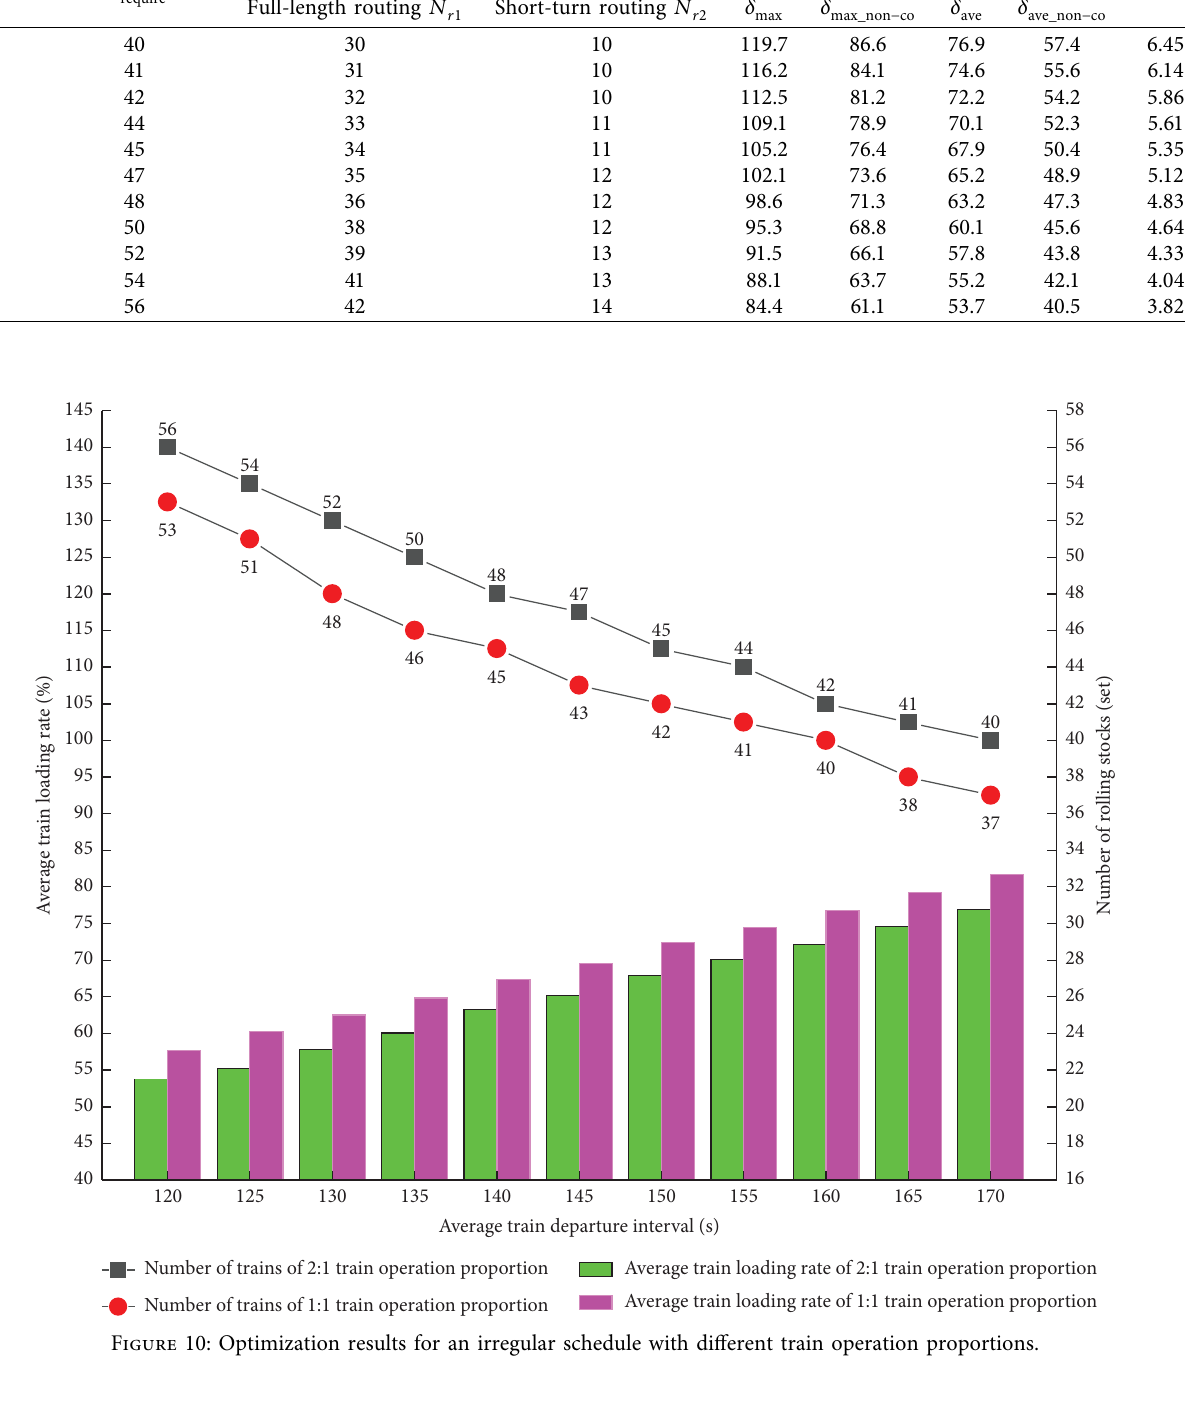
Table 4: Optimization results with 2 :1 train operation proportion of full-length and short-turn routings. h ave